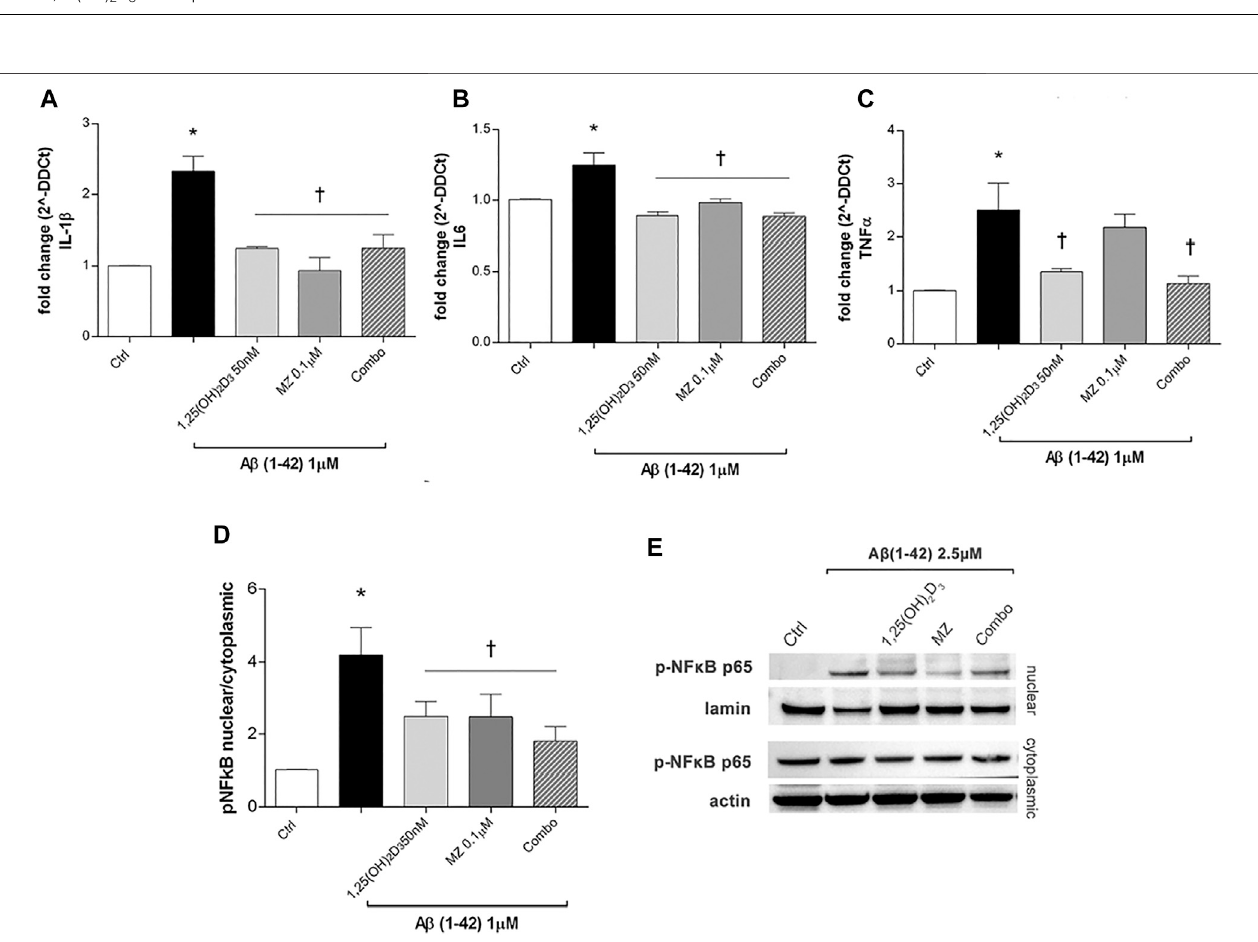
FIGURE 2 | Treatment of ARPE-19 cells with 1,25(OH) 2 D 3 , meso-zeaxanthin (MZ), and their combination (combo) counteract in fl ammation after A β (1 – 42) exposure. The treatment with 1,25(OH) 2 D 3 , MZ, and their combo reduced IL-1 β (A) , IL-6 (B) , and TNF- α (C) mRNA expression. The mRNA levels were evaluated by qPCR. (D) Westernblotanalysis.Densitometryanalysisofeachband(ratioofnuclear p -NF κ Bp-65/laminBandcytoplasmic p -NF κ Bp-65/actin)wascarriedoutwiththe ImageJ program. (E) Representative blots of nuclear and cytoplasmic extracted proteins from control and treated cells. Each bar represents the mean value ± SD ( n (cid:2) 5; each run in triplicate). One-way ANOVA and Tukey ’ s post hoc test for multiple comparisons were carried out. * p < 0.05 vs. control; † p < 0.05 vs. A β .